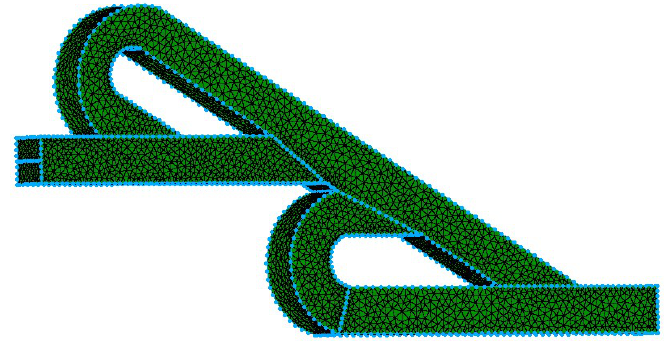
Figure 2. Micromixer mesh.